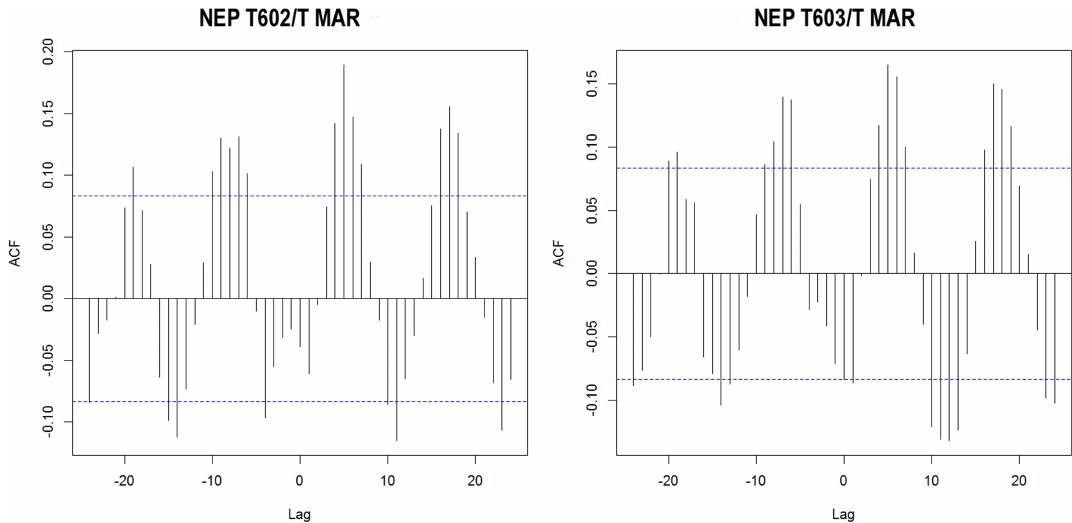
Figure 7. Cross correlations of the hourly temperature values. ACF is the autocorrelation function on the y axis; one lag equals 1h on the x axis. Comparisons are made between the MAR probe (T MAR) and T602 (NEP T602) on the left side and MAR (T MAR) and T603 (NEP T603) on the right. The horizontal dashed lines indicate the point of statistical significance at ACF = 0.8, with the lines above towards 1 and below towards − 1 being